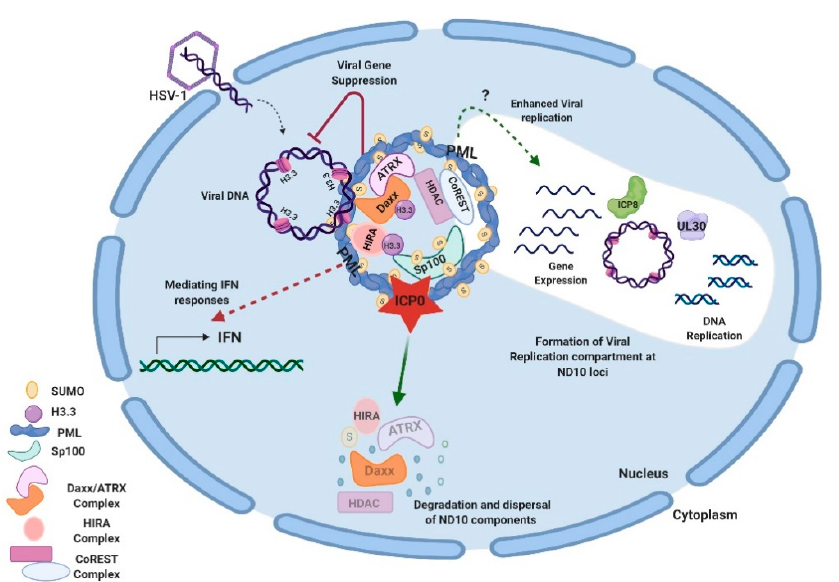
Figure 1. Interactions between HSV-1 and ND10 in the lytic cycle. HSV-1 injects its naked double- stranded DNA into the nucleus of the infected cell. ND10 components converge to the incoming DNA and impose suppression on the viral DNA. Specifically, Daxx/ATRX, and HIRA complexes deposit H3.3 histones on viral DNA to create the heterochromatin silencing. PML is an effector to mediate the IFN response in HSV-1 infection. Newly expressed ICP0 counteracts gene repression by degrading PML and Sp100 and dispersing ND10. Viral genes get expressed and replication compartments form at the ND10 loci after the ND10 dispersal. Viral proteins such as ICP8 (ssDNA binding protein) and UL30 (viral DNA polymerase) are typical markers for the replication compartments. The efficiency of viral replication can be reduced or enhanced by a PML depletion, depending on experimental conditions. Components of the CoREST complex are recruited to ND10 and reside in the viral replication compartments. This figure was created with BioRen- der.com.